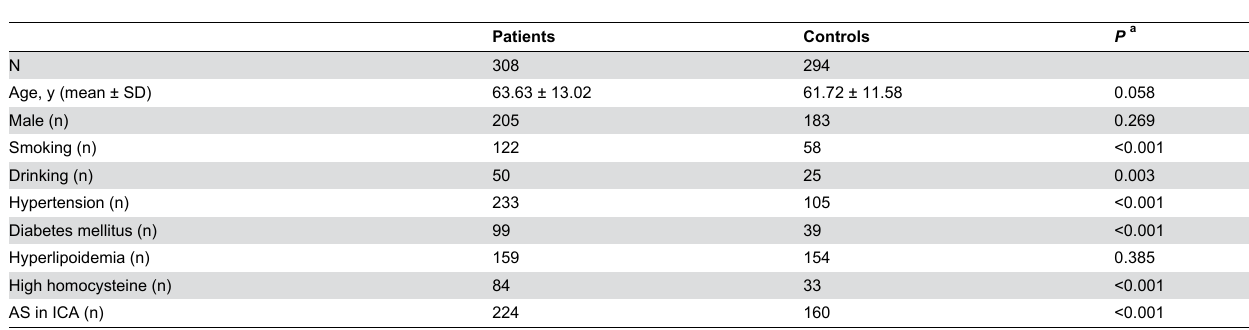
Table 1. Population characteristics.